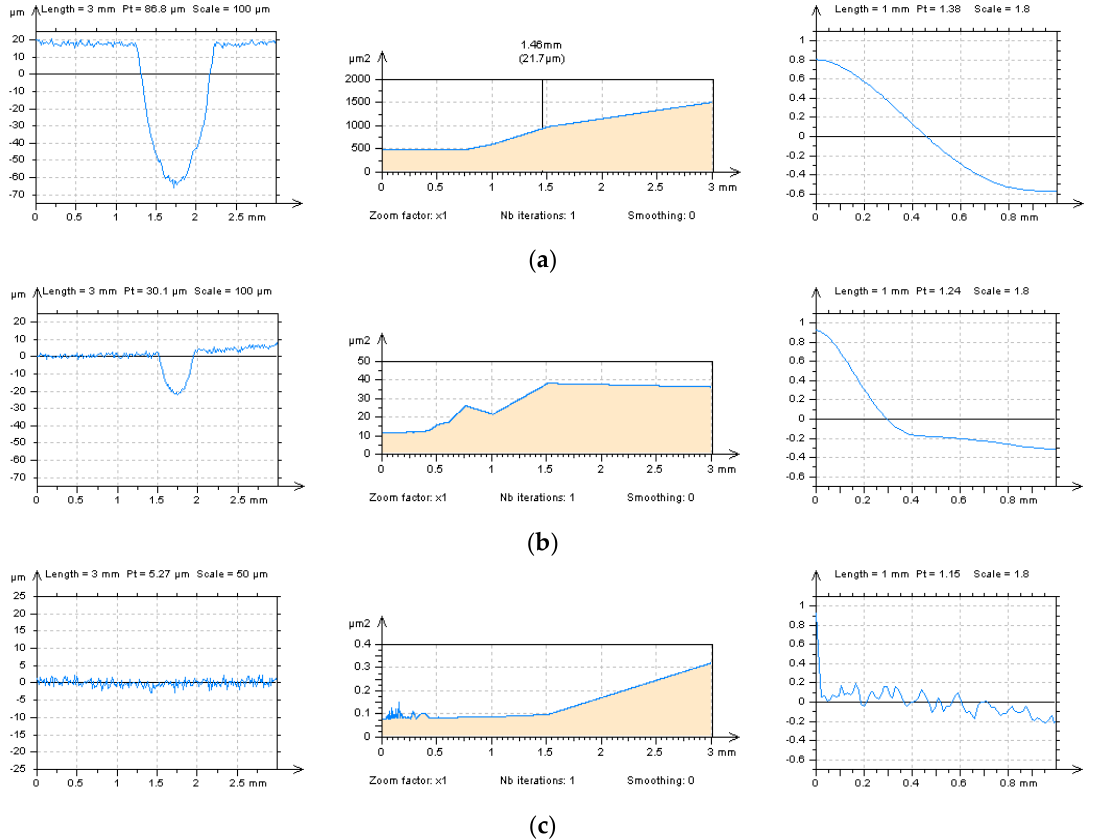
Figure 7. Profiles, their PSDs and ACFs (defined for 1 mm bandwidth) respectively, extracted from cylinder liner (running- in) surface texture measured with 0.5 mm/s velocities, containing the dimples (wide oil pockets) with a depth equal to 80 μ m ( a ), 20 μ m ( b ) and free-of-dimple profile ( c ).